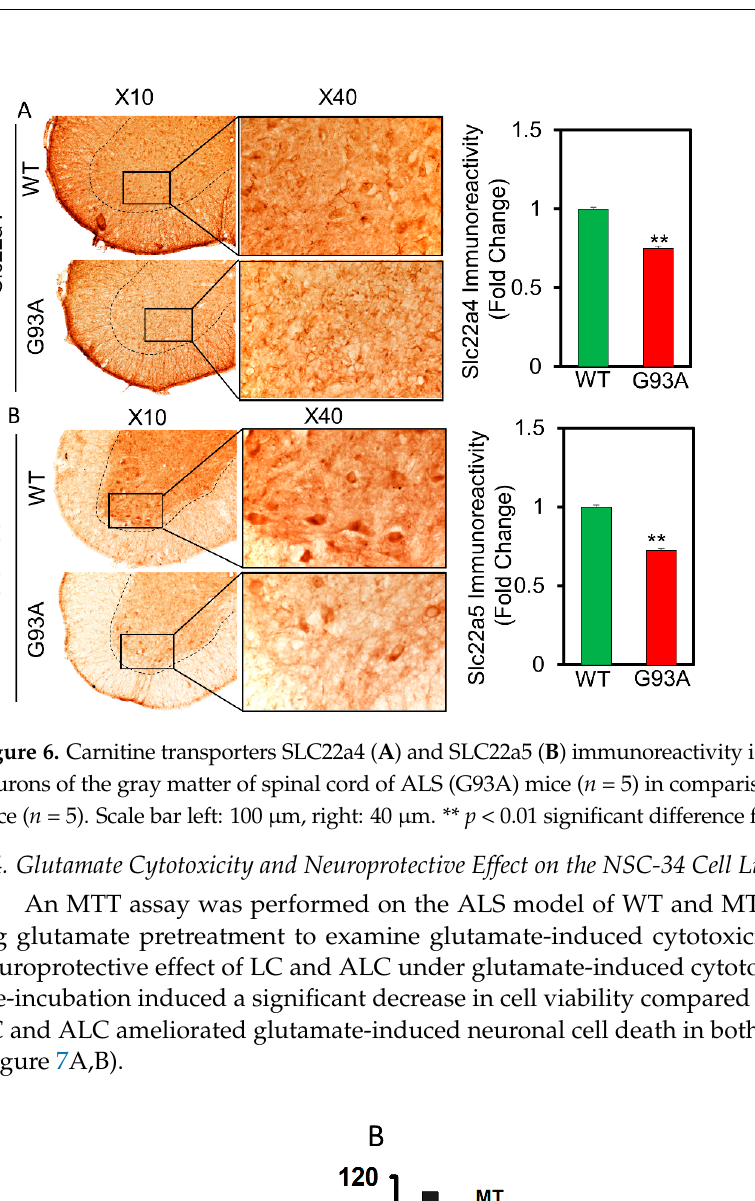
Figure 5. SiRNA transfection study in NSC-34 cell lines. Control, mOCTN1 and mOCTN2 siRNAs, at a concentration of 200 nM, were transfected using Lipofectamine 2000, and cell lines were exam- ined for ( A ) mRNA expression levels using qRT-PCR and ( B ) [ 3 H]L-carnitine uptake for 15 min at pH 7.4. Open space represents WT cell lines and dark space represents MT cell lines in both the figures. Each value represents the mean ± S.E.M ( n = 4) of four independent experiments. *** p < 0.001 and ** p < 0.01 denote significant difference from the WT control, ### p < 0.001 and ## p < 0.01 denote significant difference from the respective MT control.